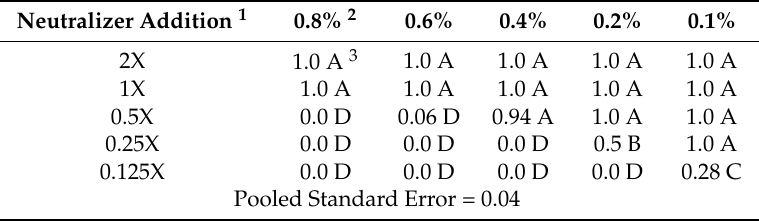
Table 1. Least squares means of the proportions of Salmonella growth or non-growth as affected by